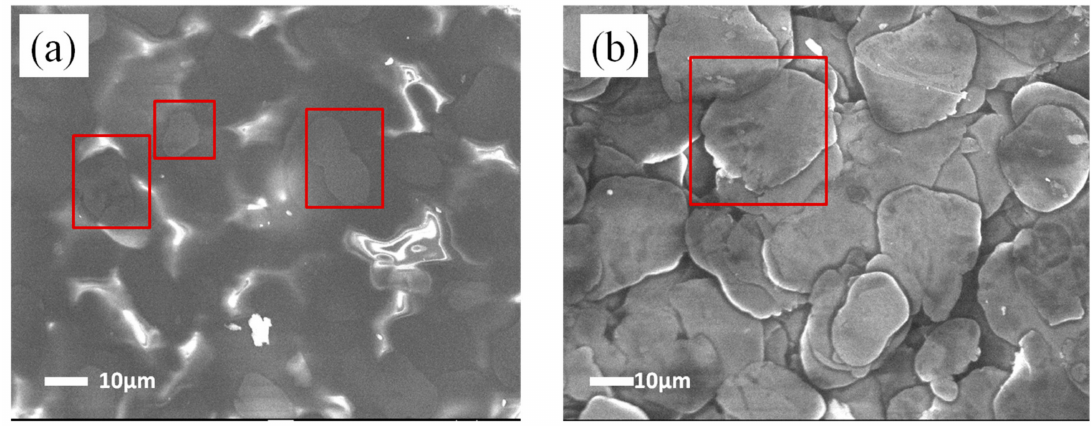
Figure 6. SEM micrographs of the coatings with ( a ) P/B = 0.5 and ( b ) P/B = 2.0 without any heat treatment.